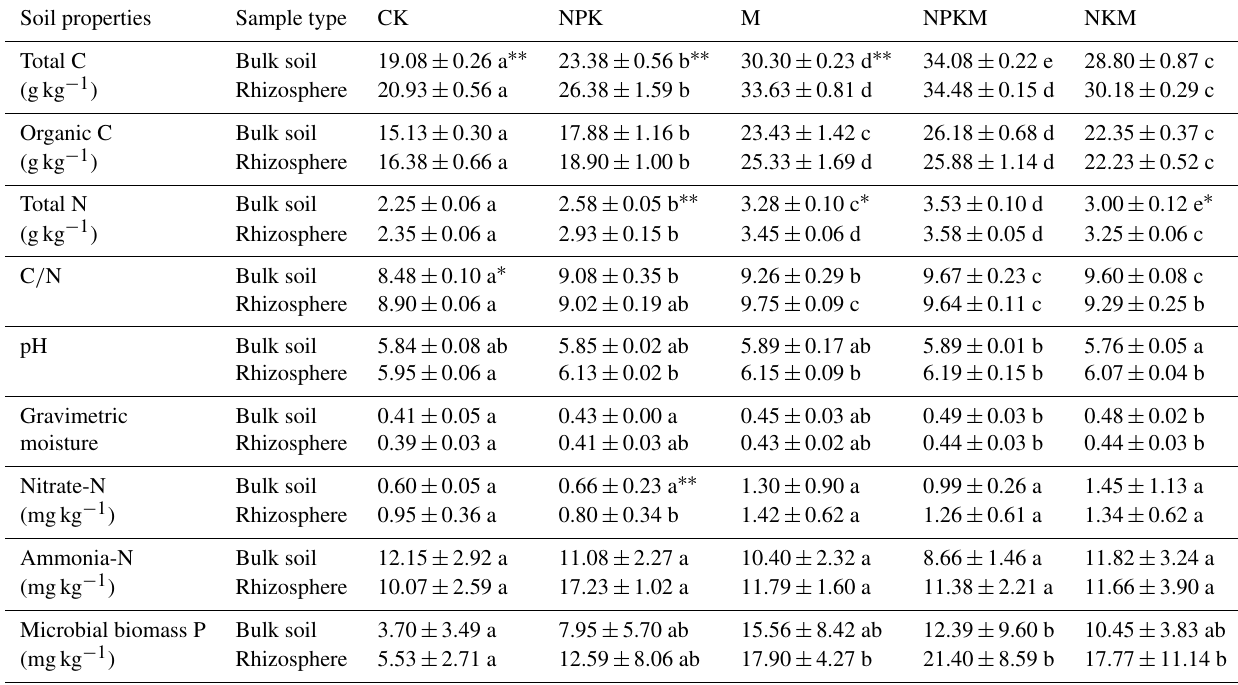
Table 1. The soil properties in five treatments (CK, NPK, M, NPKM, NKM) and two sample types (bulk and rhizosphere soils). Soil